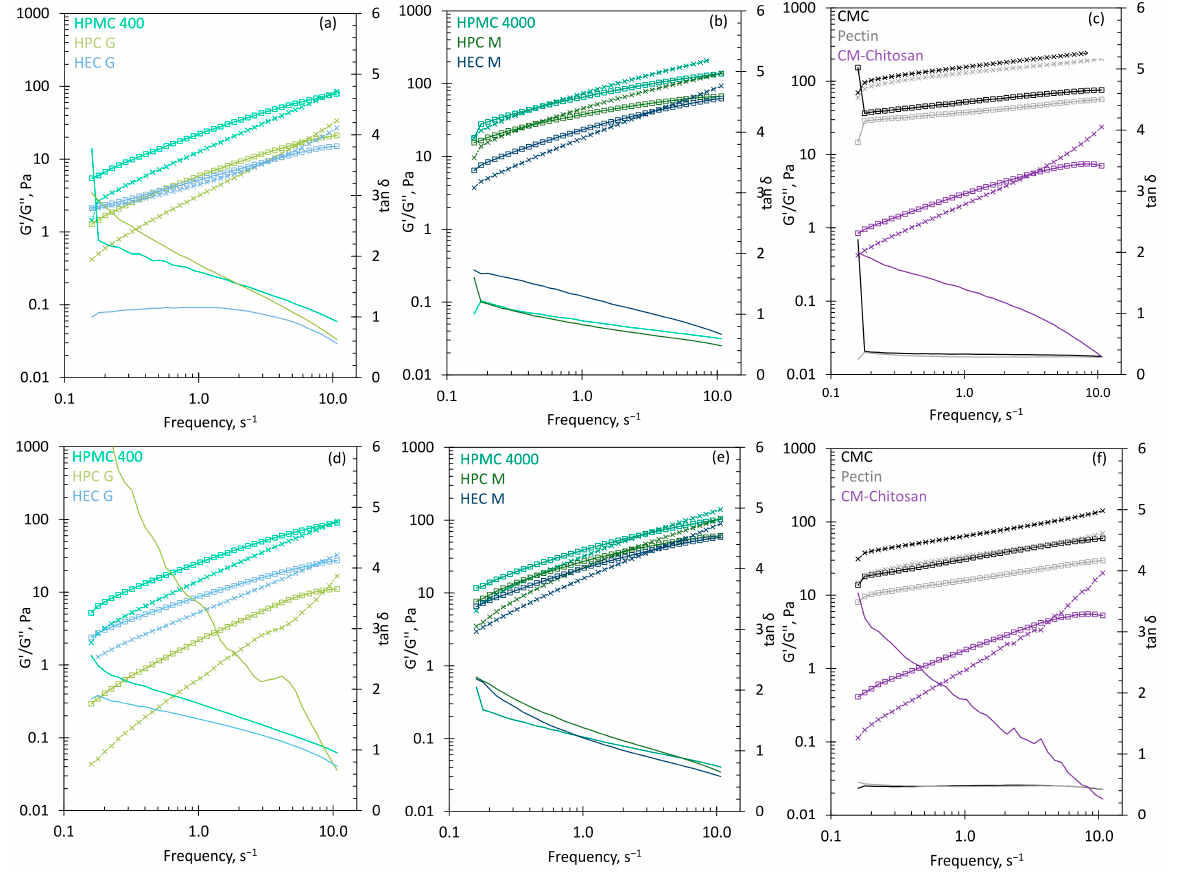
Figure 3. Frequency-dependent viscosity measurements of the mucoadhesive excipients: dotted lines with cross, elastic modulus (G (cid:48) ); solid lines with squares, viscous modulus (G (cid:48)(cid:48) ); solid lines, dissipation factor (tan δ ). ( a ) HPMC 400, HPC G, HEC G after 1 min resting time; ( b ) HPMC 4000, HPC M, HEC M after 1 min resting time; ( c ) CMC, Pectin, CM-Chitosan after 1 min resting time; ( d ) HPMC 400, HPC G, HEC G after 15 min resting time; ( e ) HPMC 4000, HPC M, HEC M after 15 min resting time; ( f ) CMC, Pectin, CM-Chitosan after 15 min resting time. The mean of the measurement of the three gels is shown; sd is not given for the clarity of the graph.